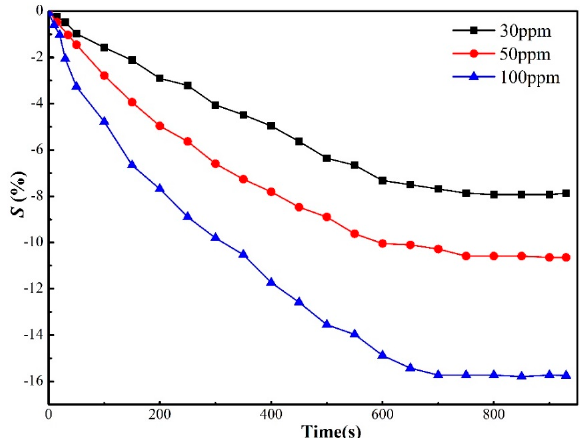
Figure 8. Response of graphene-based sensors to varied concentrates of H 2 S. Reproduced with permission from [66]. Copyright 2015 International Conference on High Voltage Engineering and Application.